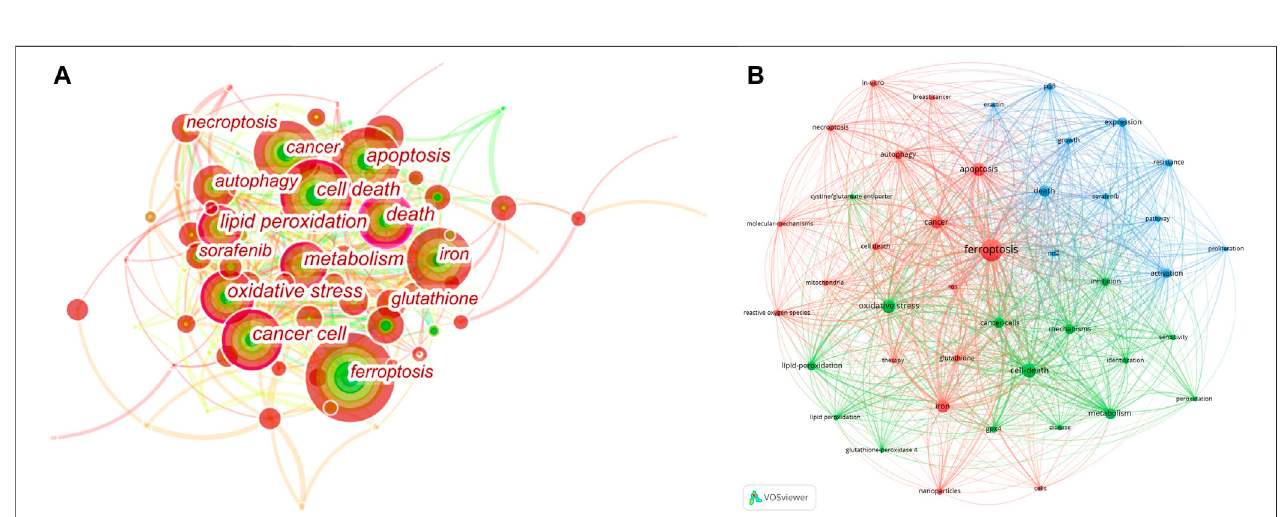
FIGURE6| AnalysisofKeywordCo-Occurrence. (A) CiteSpacenetworkvisualization map ofco-occurring keywords. (B) VOSviewernetworkvisualizationmap of co-occurring author keywords.